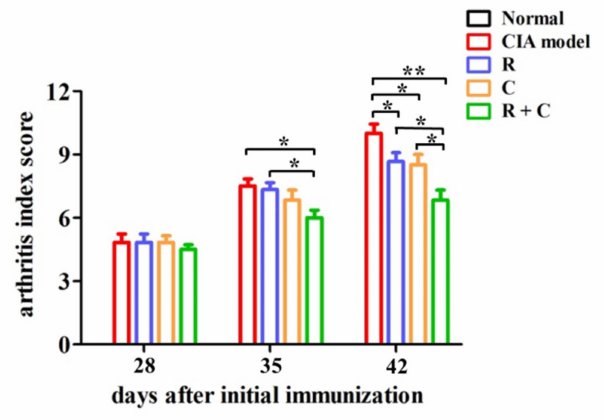
Figure 3. Effects of rosmanol (R), carnosol (C), and their combination (R + C) on arthritis index scores in CIA mice. Arthritis index scores were the cumulative scores for all four paws, which represented the overall disease severity. The arthritis index score for each group is presented as the mean ± SD ( n = 6). The significance of differences was analyzed by unpaired t -test. Note: * p < 0.05; ** p <